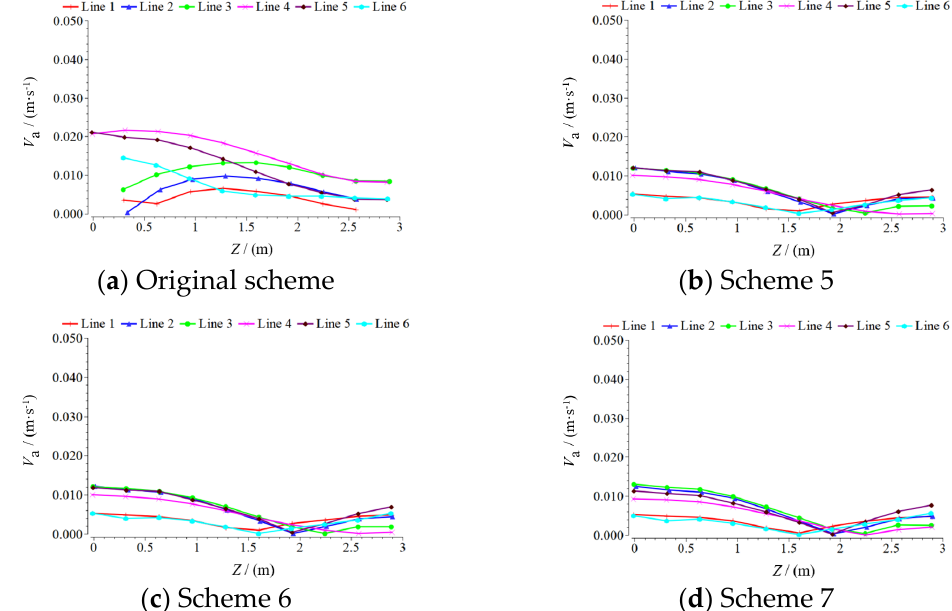
Figure 19. Diagram of axial velocity before the bell mouth in the sump 3#